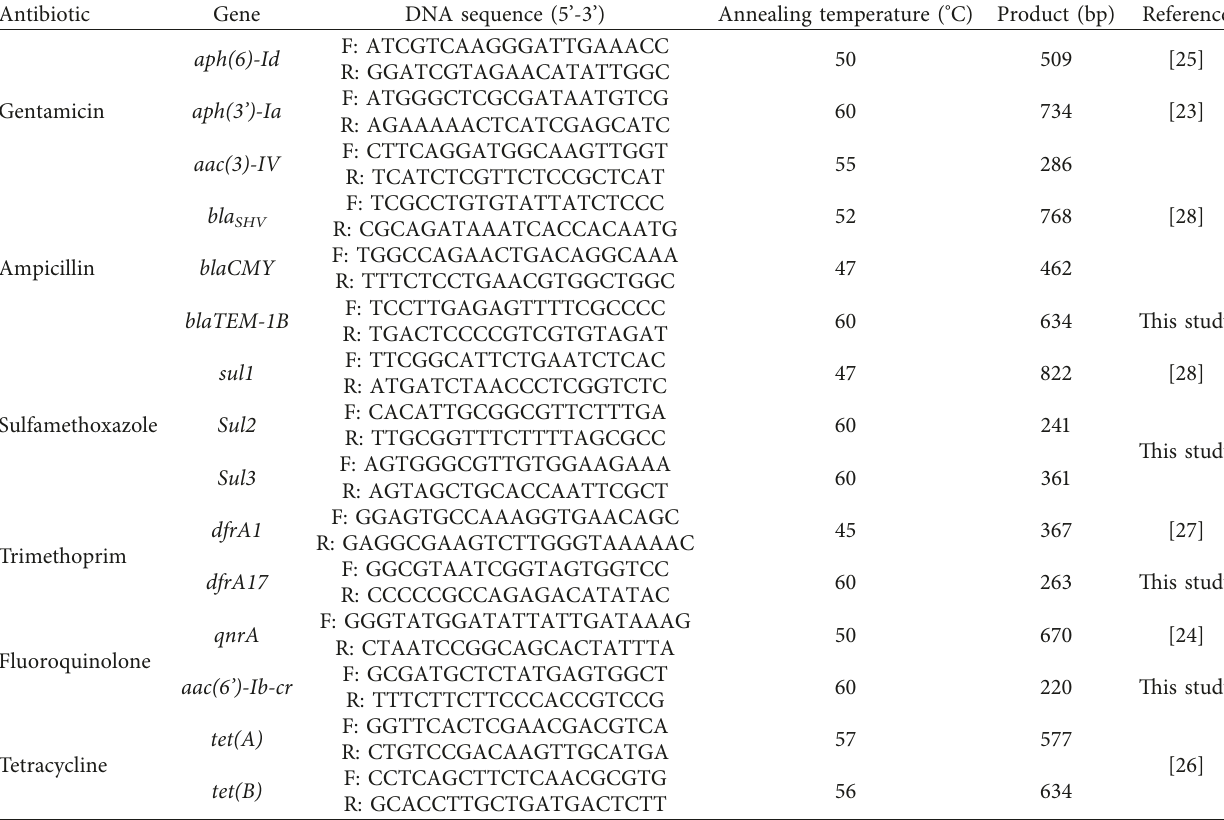
Table 1: List of primers used in the